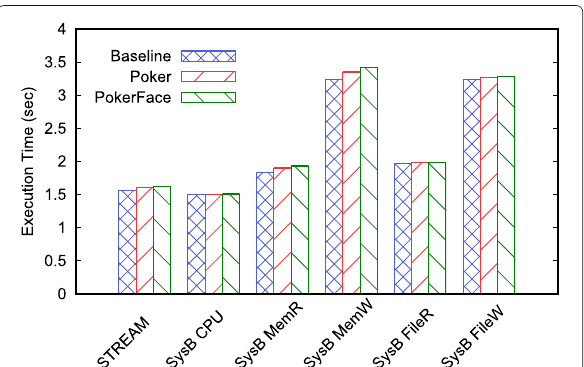
Fig. 7 PokerFace performance overhead on Parsec benchmark. The graph shows the overhead incurred by Poker on the Parsec benchmark suite. The benchmark suite consists of different programs which perform a variety of tasks like cache-aware simulated annealing (canneal), frequent itemset mining (freqmine), online clustering (streamcluster), image processing (vips), video encoding (x264), etc. Since cloud instances are regularly used for machine learning and image/video processing applications, these set of benchmarks are a representative set of real world use cases. Memory intensive applications like streamcluster and canneal suffer from 5% overhead due to Poker and a maximum of 8% overall. Other applications which are predominantly CPU intensive like blackscholes (Black-Scholes partial differential equation), ferret (content similarity search) and fluidanimate(fluiddynamicsforanimation)incur